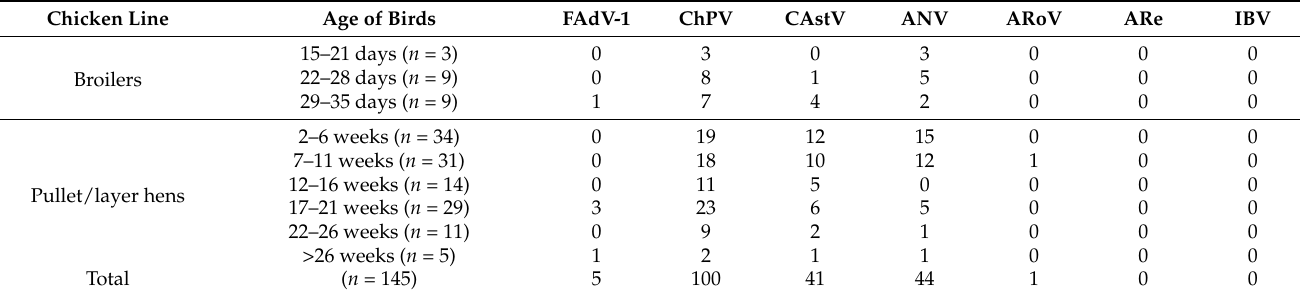
Table 7. Frequency of viruses affecting birds according to bird age 1